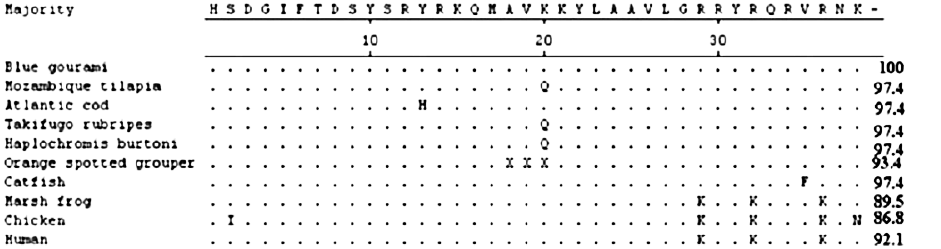
Figure 19. PRP ( A ) and PACAP ( B ) amino acid sequence comparison between blue gourami and other vertebrates. The sequence alignment was conducted using ClustalW and the MegAlign program (DNASTAR) on PRP and PACAP mature peptide sequences. Identical amino acids are represented by dots, and differing residues are shown in the single letter code for amino acids. In contrast to PRP, PACAP is highly conserved [36]. Biology 2021 , 10 , x FOR PEER REVIEW